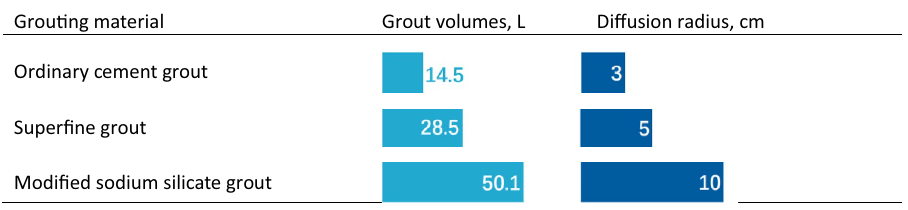
Table 5. Grout volumes of grouts at varying water–cement ratios.